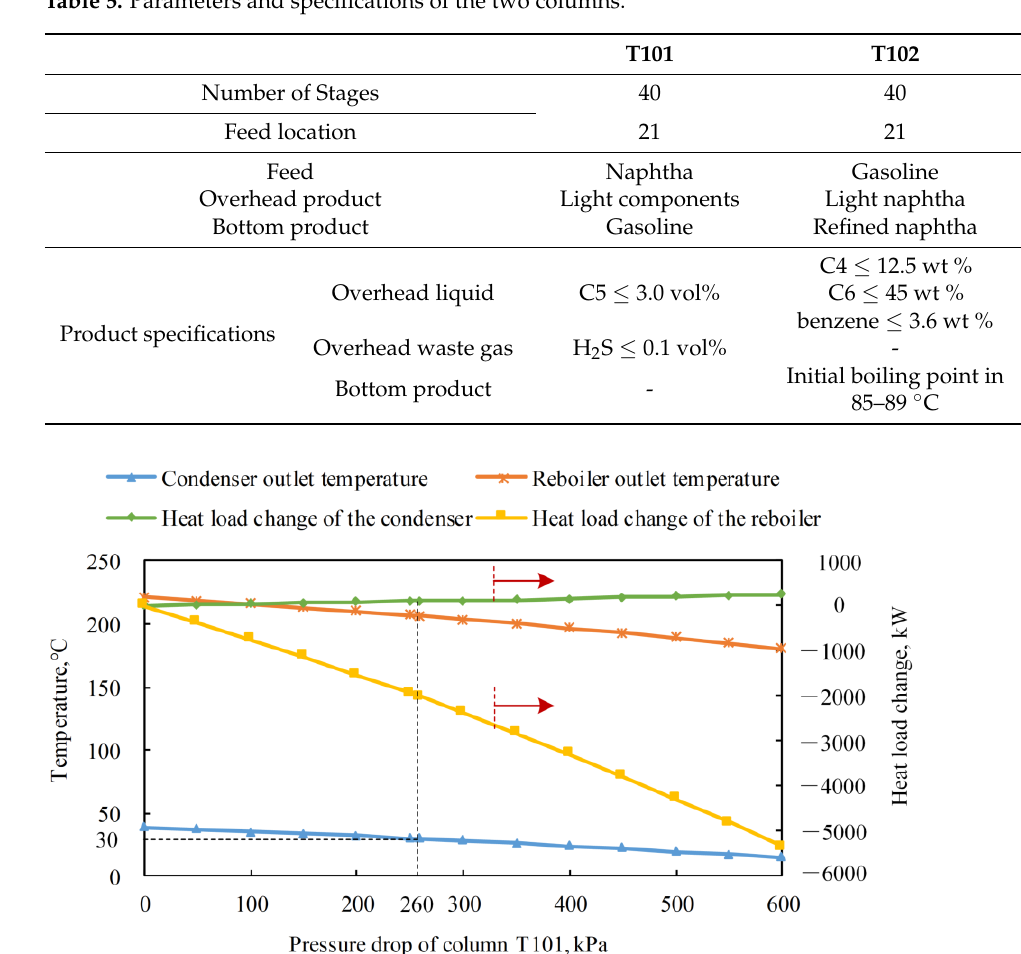
Table 5. Parameters and specifications of the two columns.